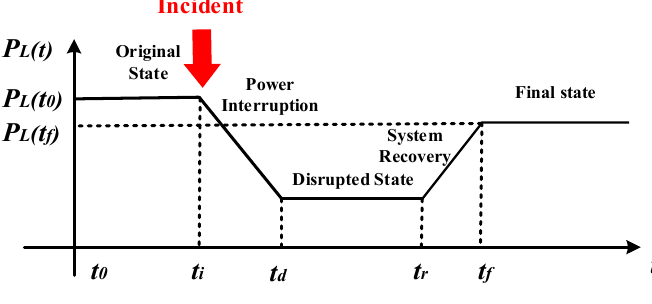
Figure 2. System operation state over time.